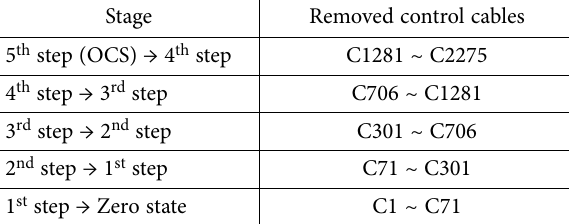
Table 1. Removed control cables in the different tensioning stages